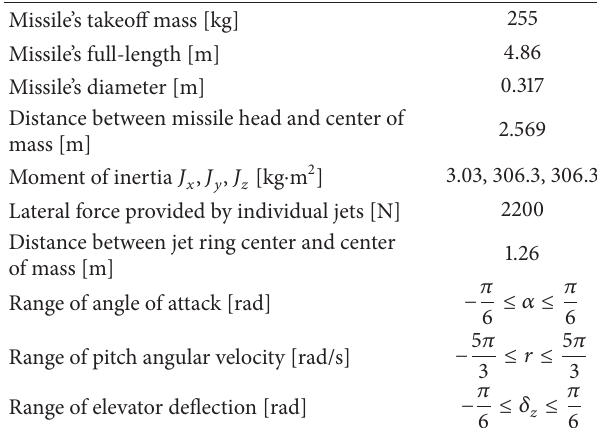
Table 1: Missile’s overall